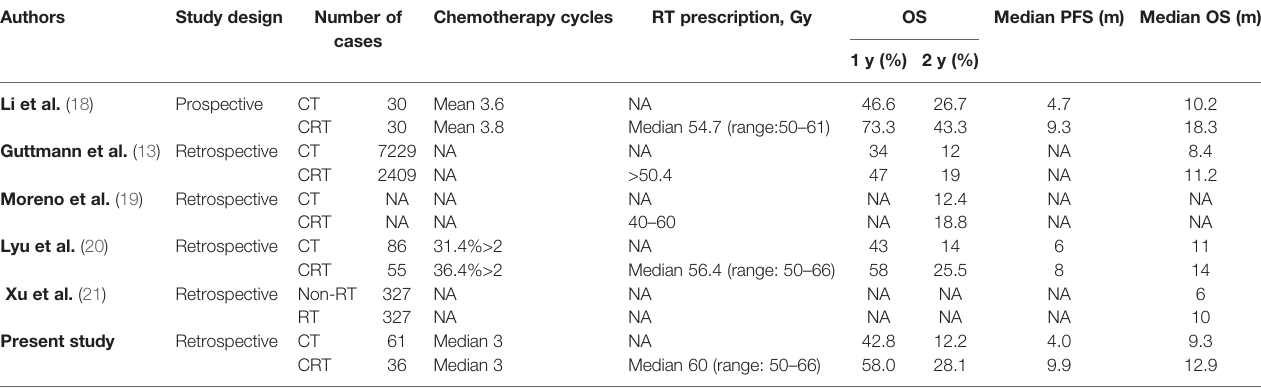
Authors Study design